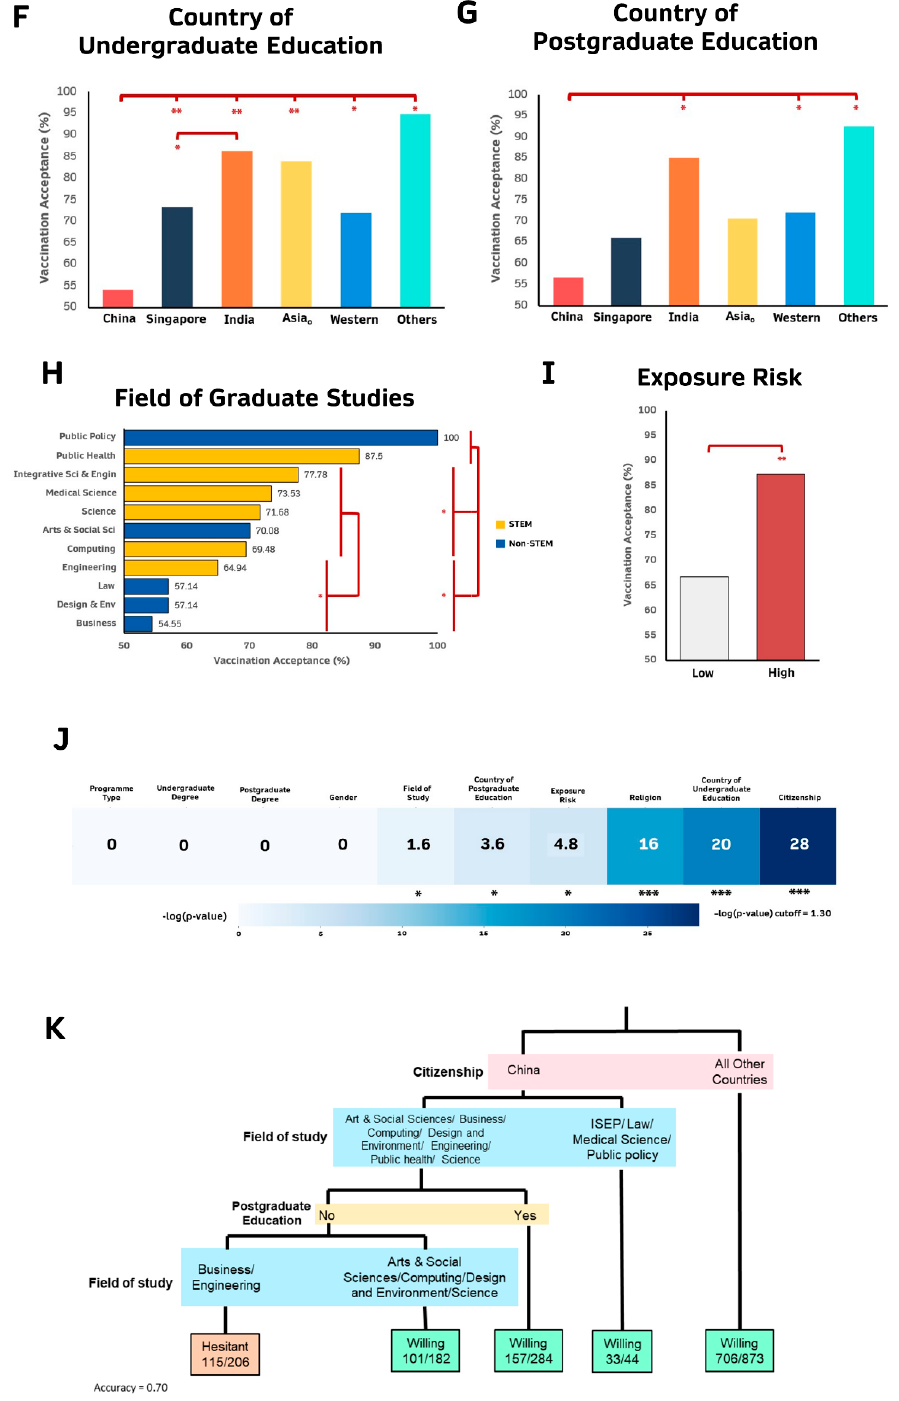
Figure 2. Percentage of respondents who are willing to be vaccinated. ( A ) Overall. ( B ) Religion; ( C ) Citizenship (See Table S2 for the specific countries for Asia o , Western and Others); ( D ) Race; ( E ) Prior Local or Overseas Education. ( F ) Country of Undergraduate Education (See Table S2 for the specific countries for Asia o , Western and Others). ( G ) Country of Postgraduate Education (See Table S2 for the specific countries for Asia o , Western and Others). ( H ) Field of Graduate Studies and ( I ) Risk Exposure of Thesis Project. ( J ) Chi-Square association of the different independent variables. ( K ) Predictors of Vaccine Hesitancy using Recursive Partitioning and Regression Trees (Accuracy = 0.7). * adjusted p < 0.05, ** adjusted p < 10 − 5 and *** adjusted p < 10 − 10 . Details of the statistics including OR and CI are found in the Supplementary Figure